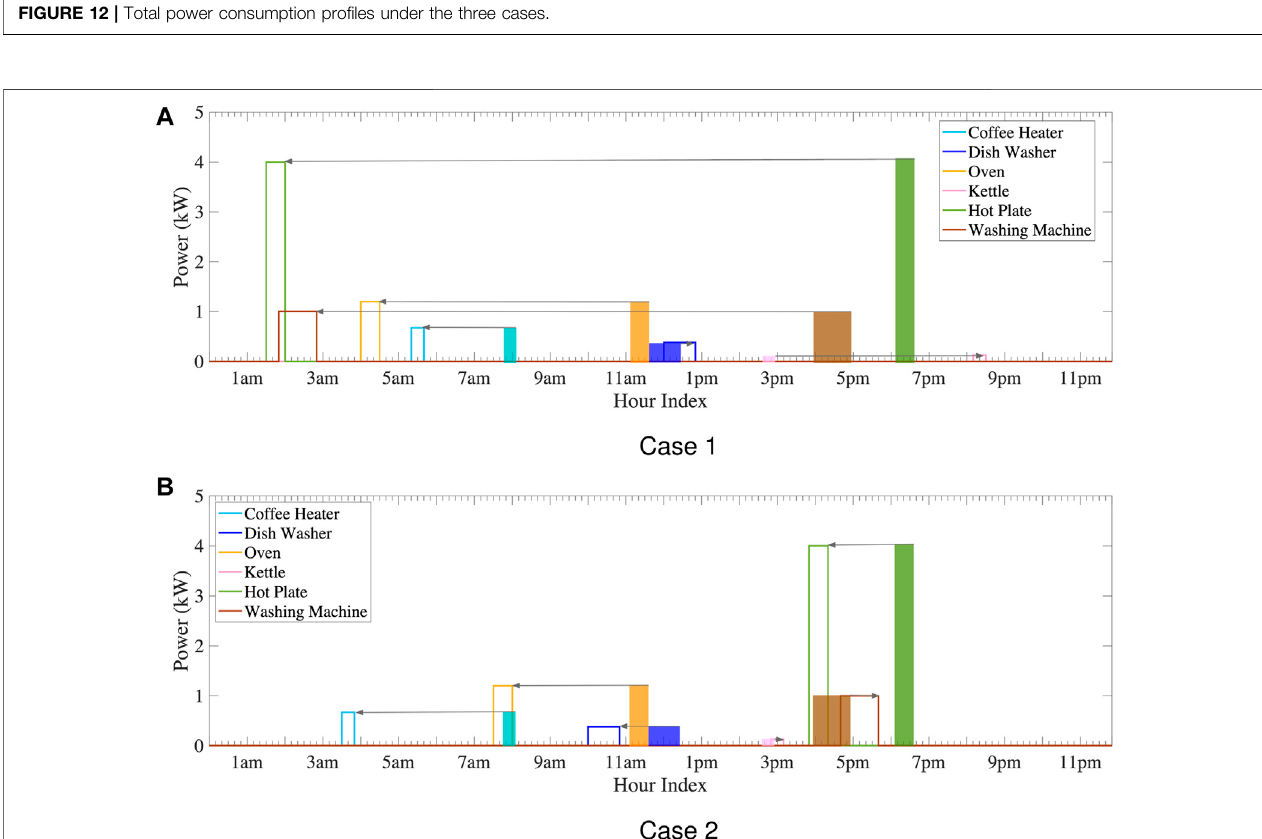
FIGURE 13 | Planned schedule of TSAs under Case 1 and Case 2 (lines: optimized completion time of each TSA by MONAA; blocks: user-speci fi ed completion time of each TSA).